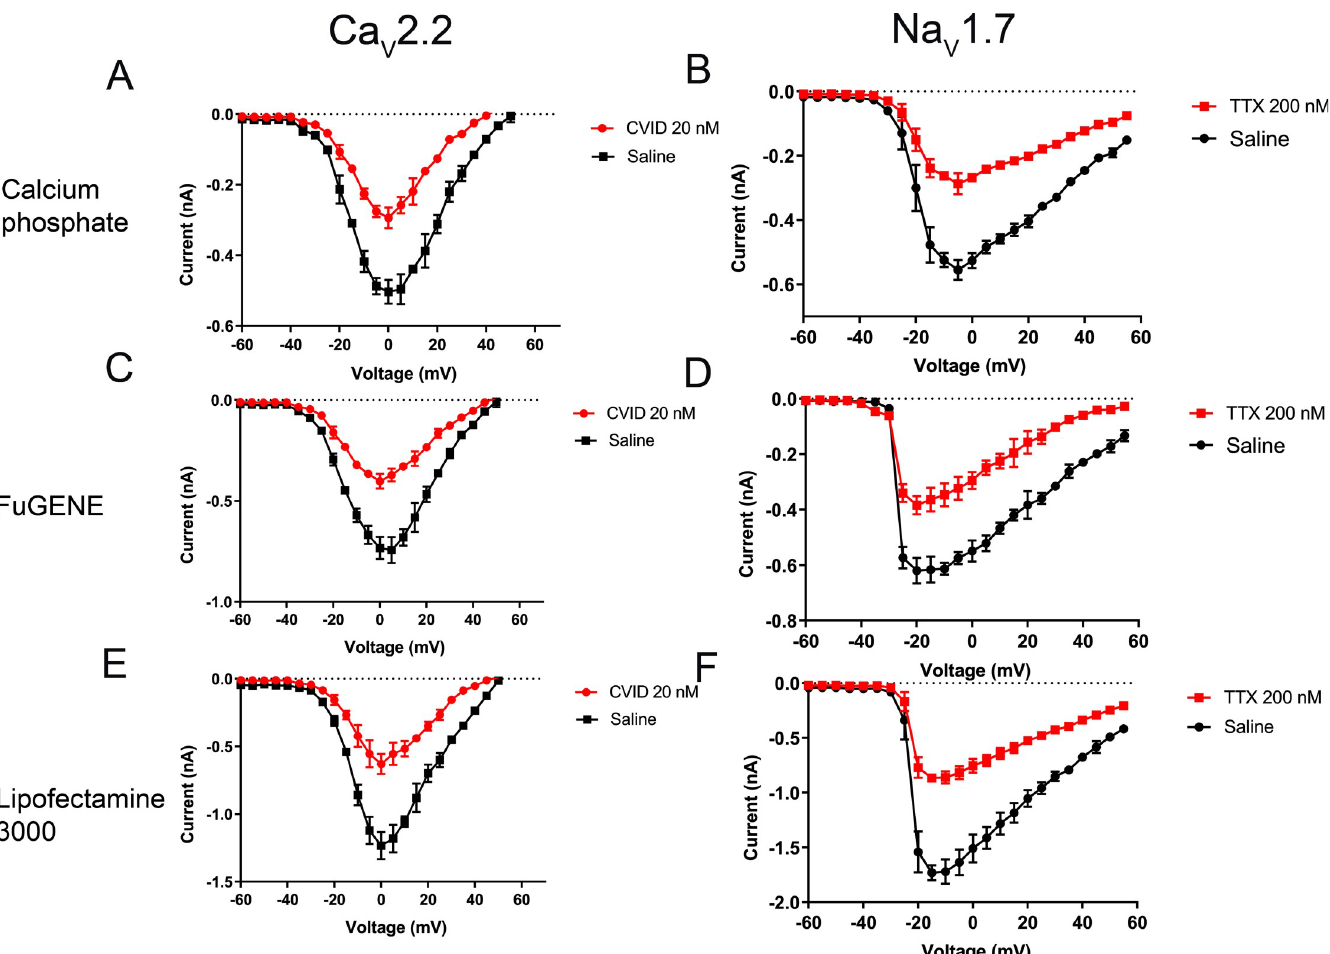
Fig 8. Current-voltage relationship of Ca V 2.2 in the presence and absence of 20 nM CVID from HEK 293T cells transfected by (A) calcium phosphate, (C) FuGENE and (E) Lipofectamine 3000. Ca V 2.2-mediated currents were evoked by depolarization steps from a holding potential of –100 mV followed by –60 mV to +50 mV in 5-mV increment. Current-voltage relationship of Na V 1.7 in the presence and absence of 200 nM TTX obtained from HEK 293T cells transfected by (B) calcium phosphate, (D) FuGENE and (F) Lipofectamine 3000. Na V 1.7-mediated currents were evoked by step depolarization from a holding potential of –80 mV followed by – 60 mV to +55 mV in 5-mV increment. Data are presented as mean ± SEM, with N = 4–9 cells per data point.